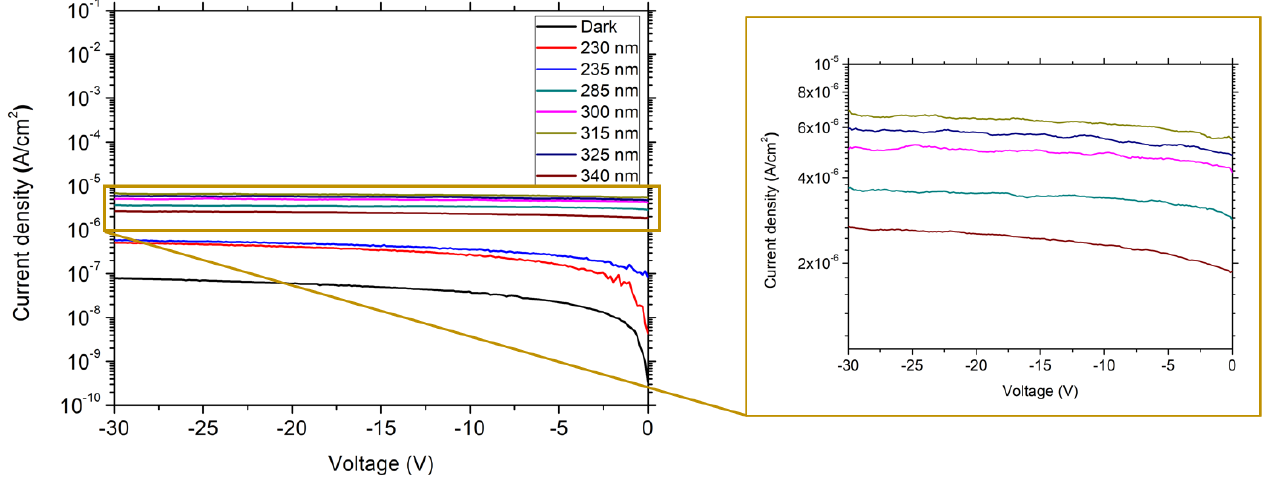
Figure 4. J–V characteristics for different UV wavelengths at RT. The incident optical power, from a monochromator, varies with the wavelength.